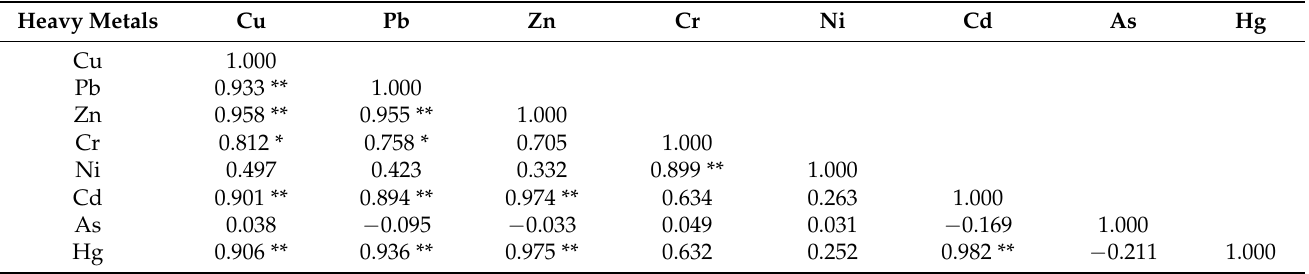
Table 4. Pearson’s correlation matrix between heavy metals ( n =